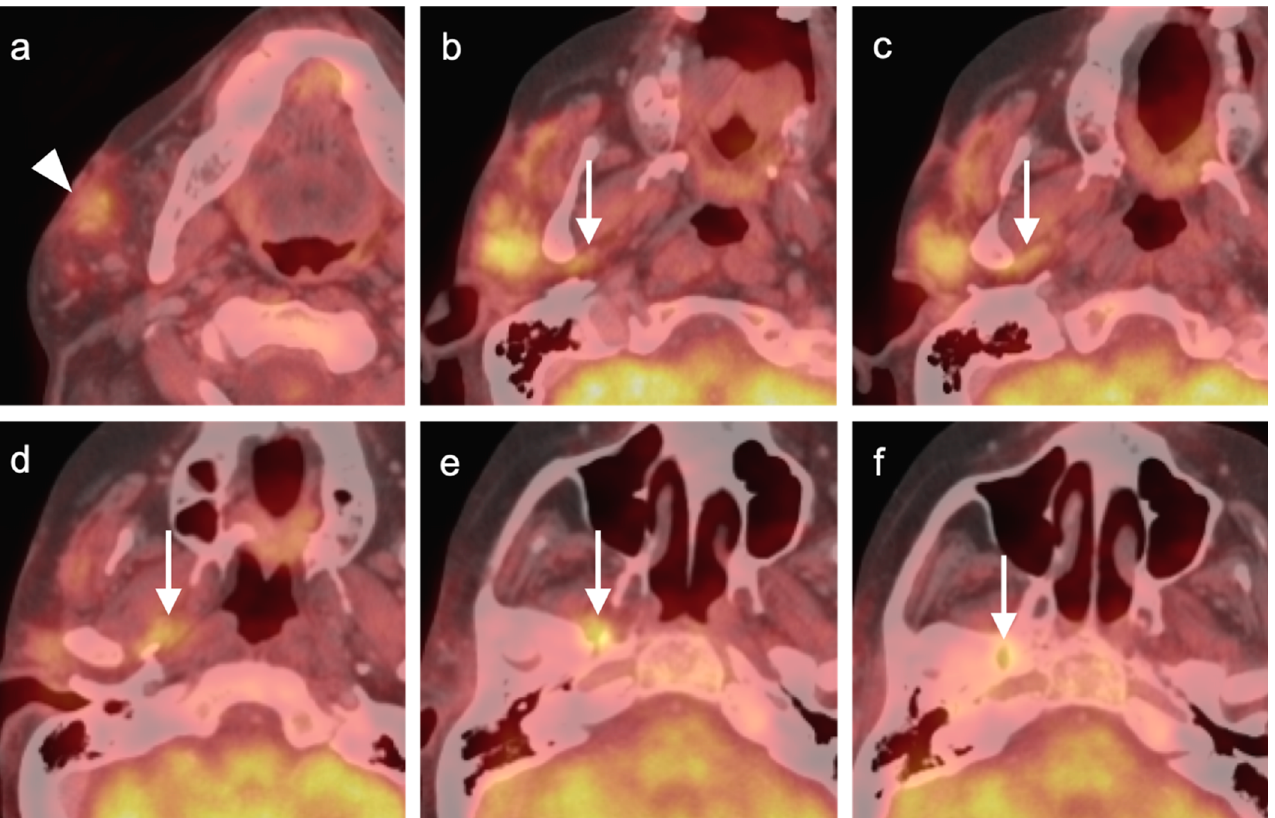
Figure 8. Perineural spread of tumor. ( a ) Hypermetabolic infiltrative tumor in the right parotid (white arrowhead, poorly differentiated carcinoma); ( b – e ) hypermetabolic tumor (white arrow) along the distribution of the right auriculotemporal nerve (branch of the mandibular nerve, V3); ( f ) extension of metabolically active tumor into the right foramen ovale (white arrow).